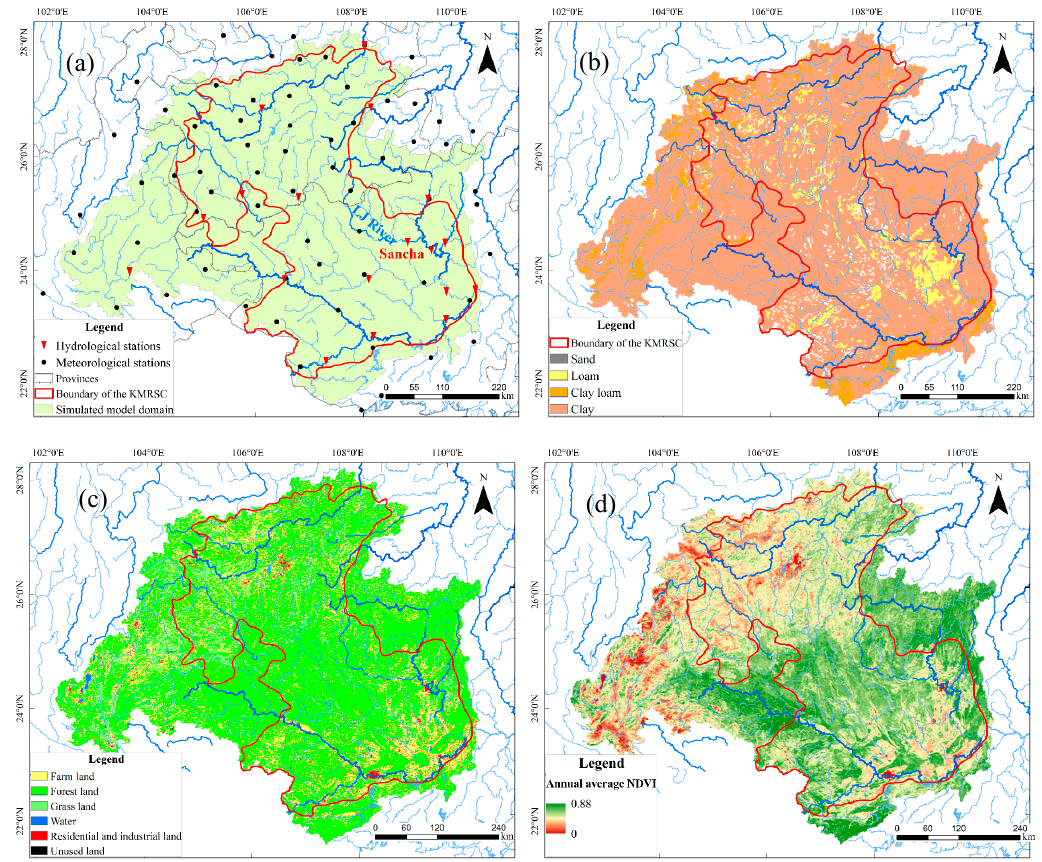
Figure 3. Representative data maps in the modelling domain: ( a ) meteorological and hydrological stations; ( b ) soil types; ( c ) land-use in 2015; and ( d ) annual average value of Normalized Difference Vegetation Index (NDVI ) .